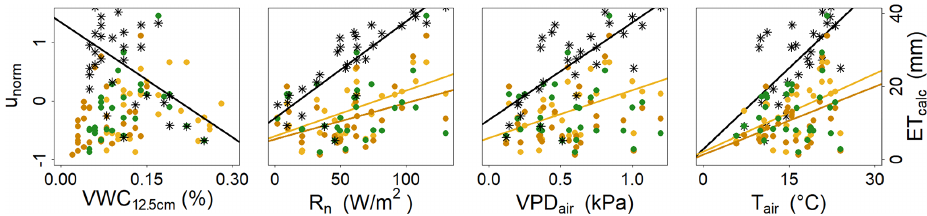
Figure 3. Linear correlation of hydroclimatic variables (VWC 12 . 5 , R n , VPD air , T air ) with measured weekly u norm at the tree site (asterisk) and calculated weekly ET calc at the grassland (yellow), shrub (orange) and tree (green) sites.